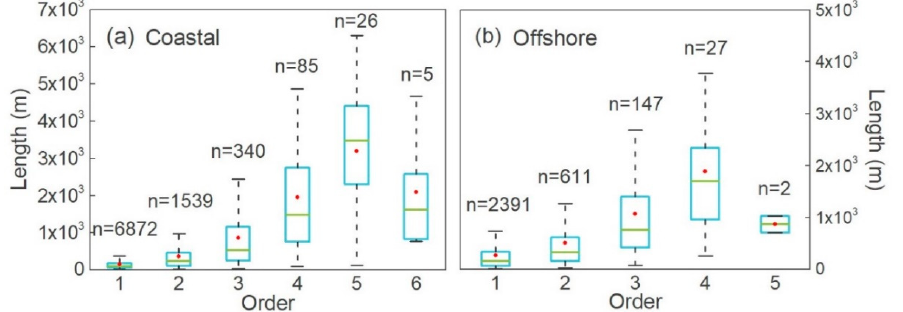
Figure 6. Relationship between the order and length of ( a ) coastal and ( b ) offshore tidal creeks. The red dots denote the mean length, the green line is the median, and n is the number.